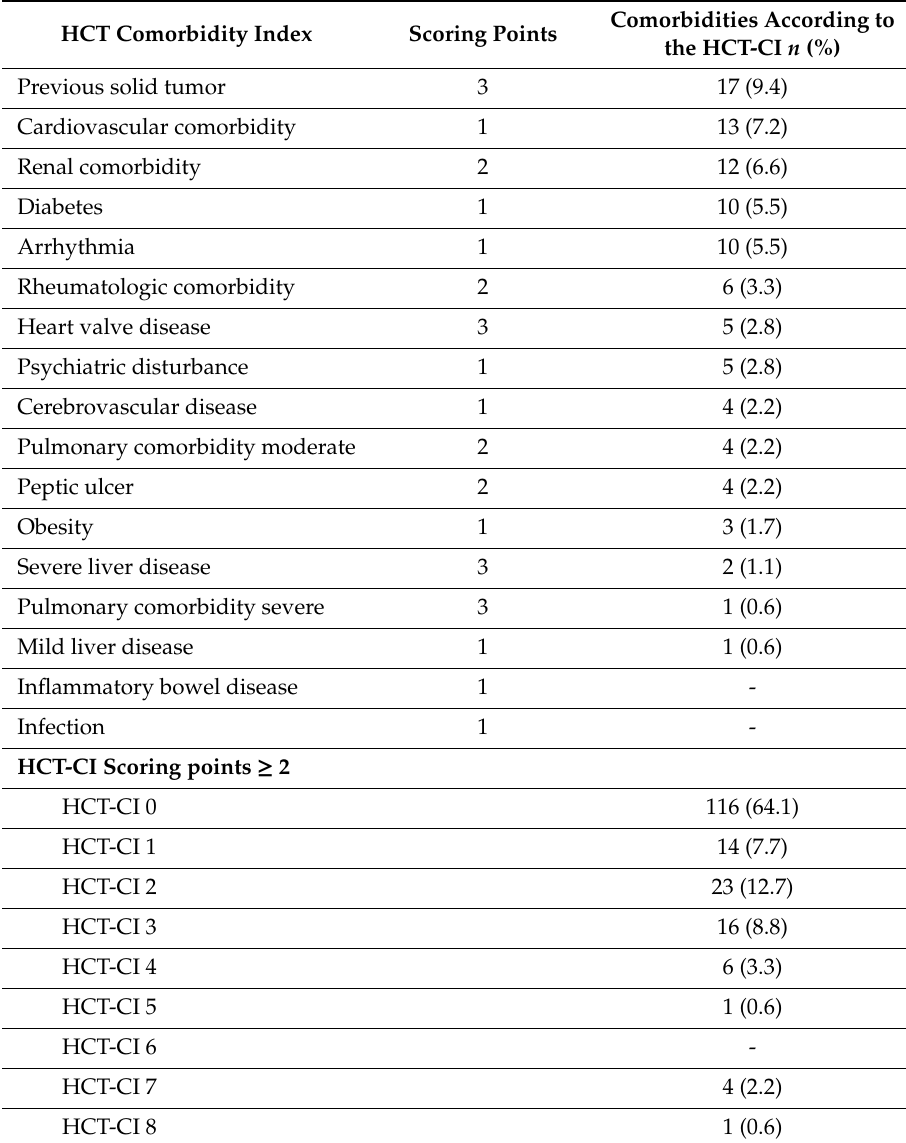
Table 3. Comorbidities as defined by the Haematopoetic Cell Transplantation-specific Comorbidity Index (HCT-CI). HCT Comorbidity Index Scoring